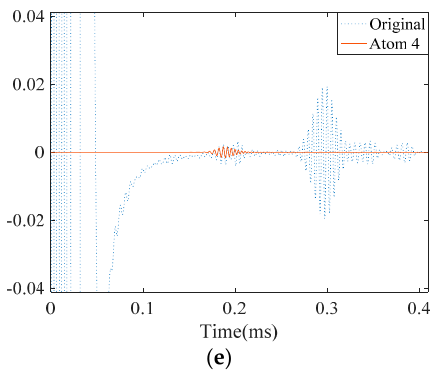
Figure 17. The experimentally measured signal in a pipe with two cracks and its approximation by SDMP: ( a ) the originally measured signal; ( b ) approximated atom 1—the incident signal; ( c ) approximated atom 2—the reflection from the pipe end; ( d ) approximated atom 3—the reflection from the first crack; and ( e ) approximated atom 4—the reflection from the second crack.